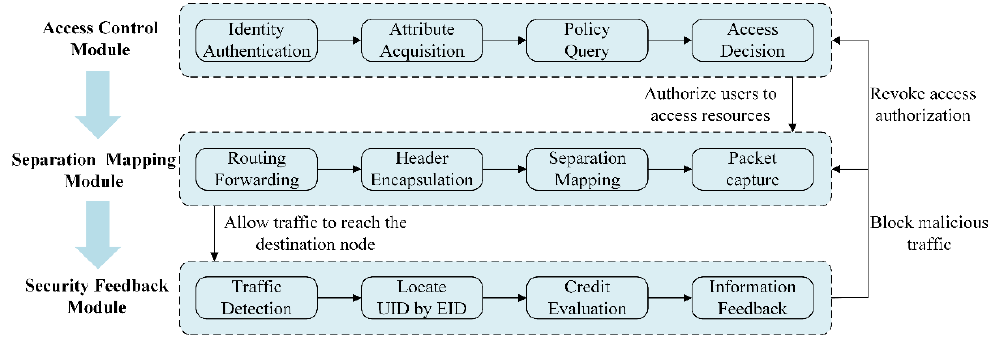
Figure 2. System